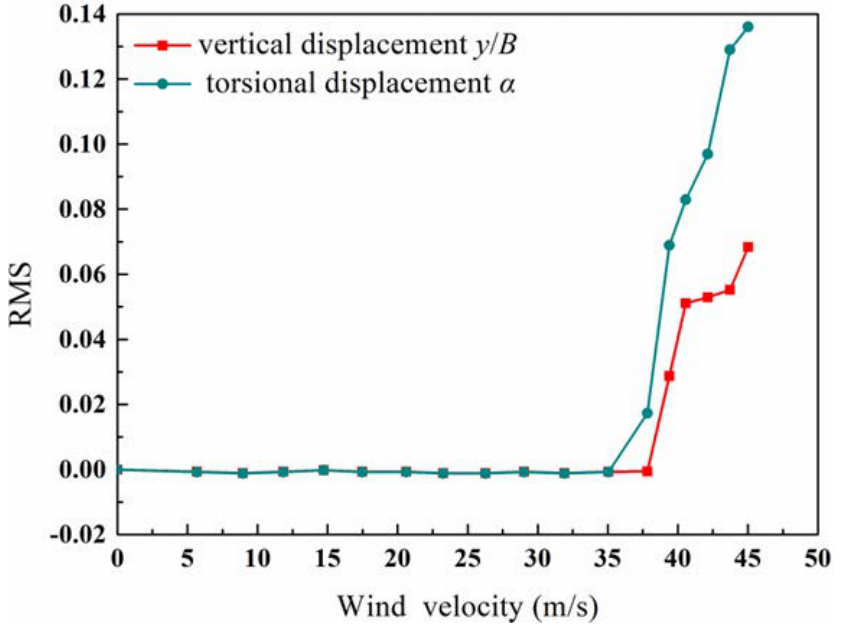
Figure 7. Nondimensionalized RMS displacements of the big wind fairing section, +5 ◦ angle of attack. Figure 8 shows the time histories of the torsional and the vertical displacements at wind velocity U = 44.7 m/s and their Fourier spectrum analysis. It can be found that the soft flutter amplitude of the section is dominated by the torsional vibration, and the stable vertical amplitude is only about 2 cm. In the Fourier analysis, there is only one torsional vibration frequency, which is the model torsional frequency, however, the vertical vibration spectrum contains multiple vibration frequencies, and these vertical vibration frequencies approximately present a multiplicative relationship. Each flutter derivative of Scanlan linear self-excited forces is a function of a single frequency rather than multiple frequencies, so the presence of multiple frequency components in Figure 8d makes the Scanlan equations [40,41] no longer valid, and the self-excited forces may be modified by the higher order frequency terms.